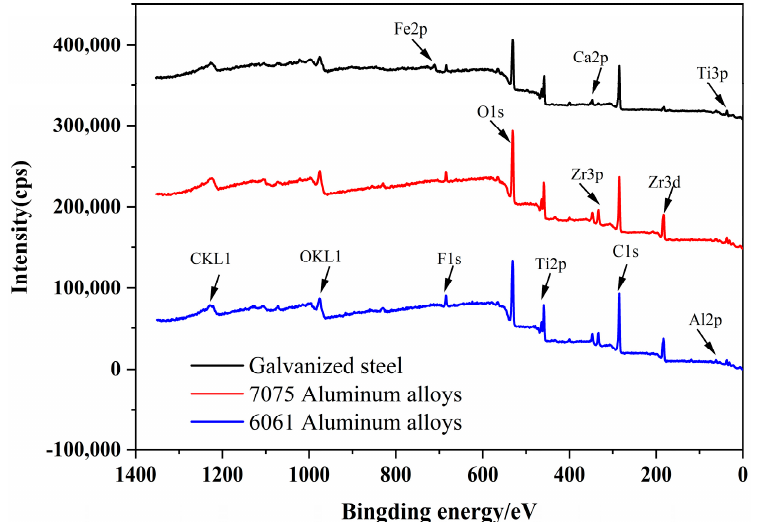
Figure 10. XPS spectra for synchronous chemical conversion coatings of 6061 aluminum alloy/7075 aluminum alloy/galvanized steel.